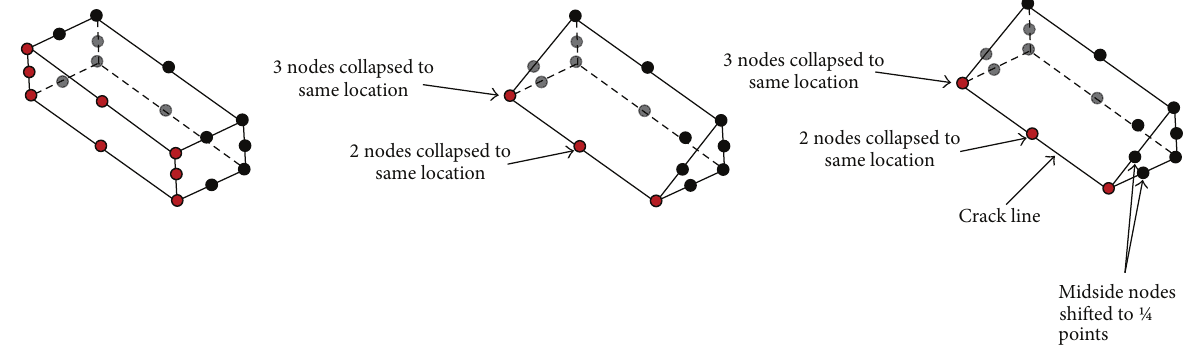
Figure 5: 20-node crack tip element (wedge).